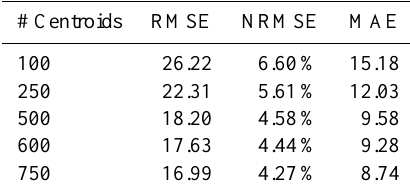
Table 3. Regression results varying the number of centroids M , ex- pressed in terms of RMSE, NRMSE and